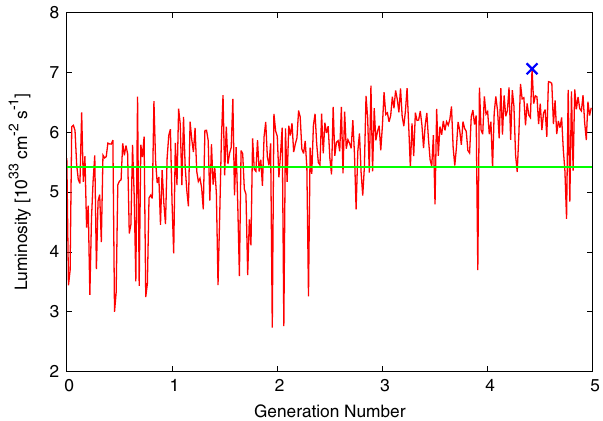
FIG. 4. GA at work: beam-beam simulation of the MEIC with five generations of 64 individuals each, sampling the 4D tune space ½ 0 : 5 ; 0 : 55 (cid:6) 4 . The green line represents the design luminos- ity. The optimization locates a near-optimal working point in fewer than 300 simulations (blue (cid:5)